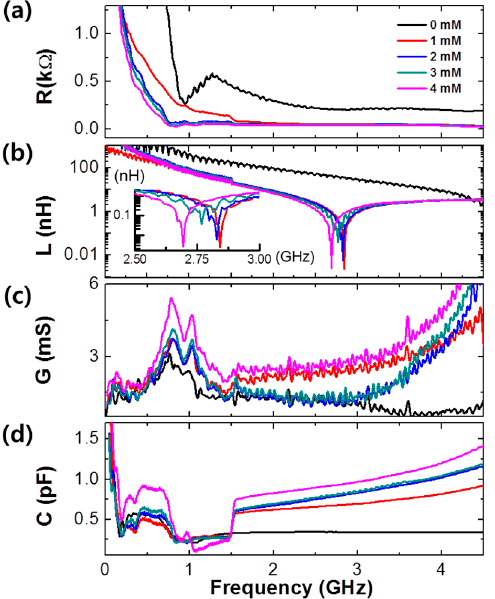
Figure 5. ( a ) Resistance, R ; ( b ) inductance, L ; ( c ) shunt conductance, G ; and ( d ) shunt capacitance, C , of PBA/RGO device according to adding glucose with different concentrations from 0 to 4 mM.